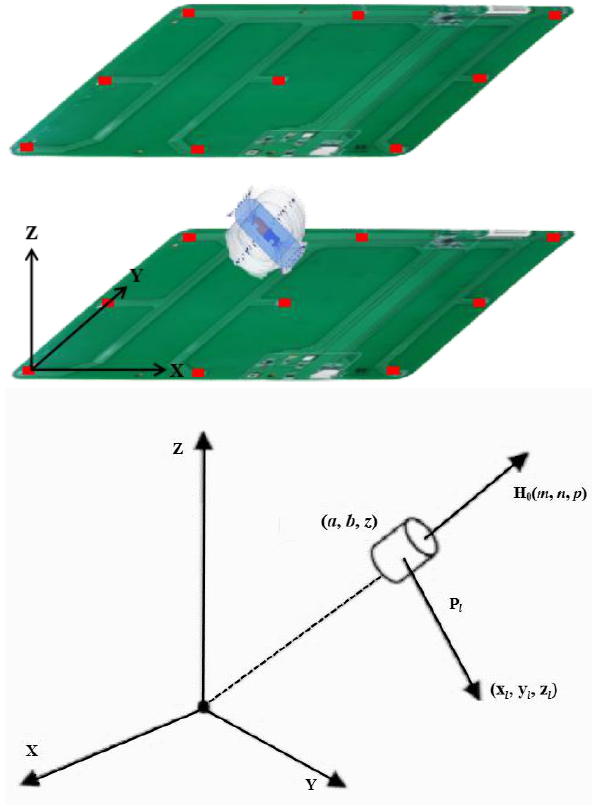
Figure 6. The diagrammatic drawing of magnetic sensor-based localization principle and the magnetic dipole